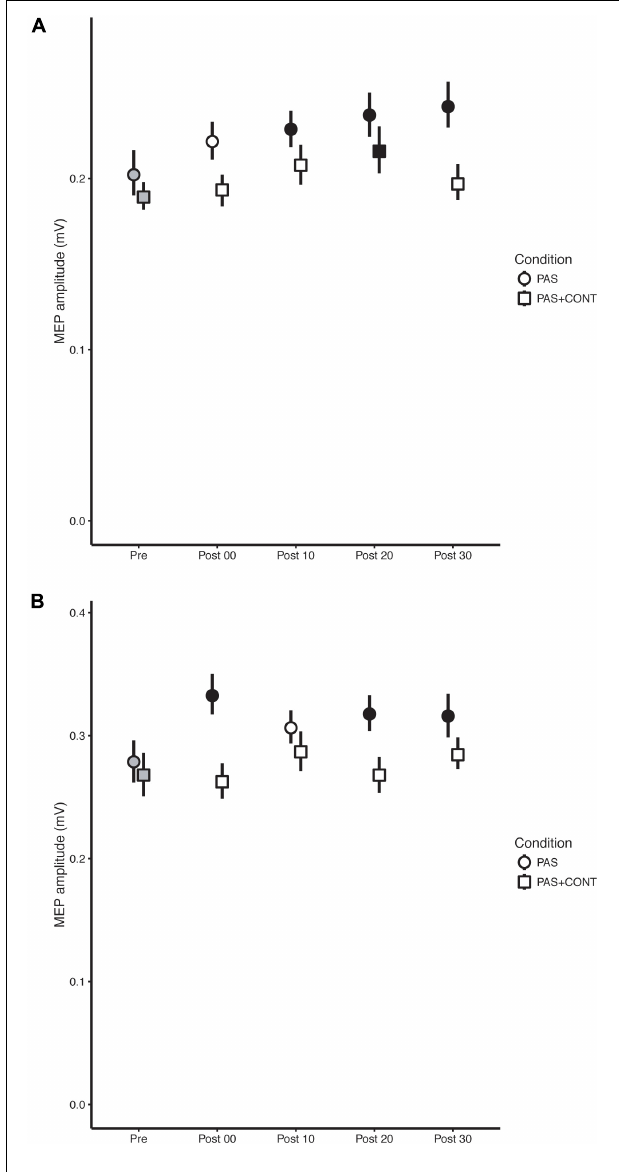
FIGURE 1 | Young healthy participants. The mean ( n = 27) MEP amplitude values obtained for the flexor carpi radialis (FCR) muscle (A) and extensor carpi radialis (ECR) muscle (B) at each time of measurement (Pre, Post00, Post10, Post20, and Post30), are shown for the respective experimental conditions: paired associative stimulation (PAS); PAS plus contraction (PAS + CONT). The error bars are the 95% “Cousineau-Morey” confidence intervals. The values recorded prior to the intervention are shown as filled gray symbols. Instances in which a post-intervention measurement differed reliably from the pre-intervention value are shown as filled black symbols.